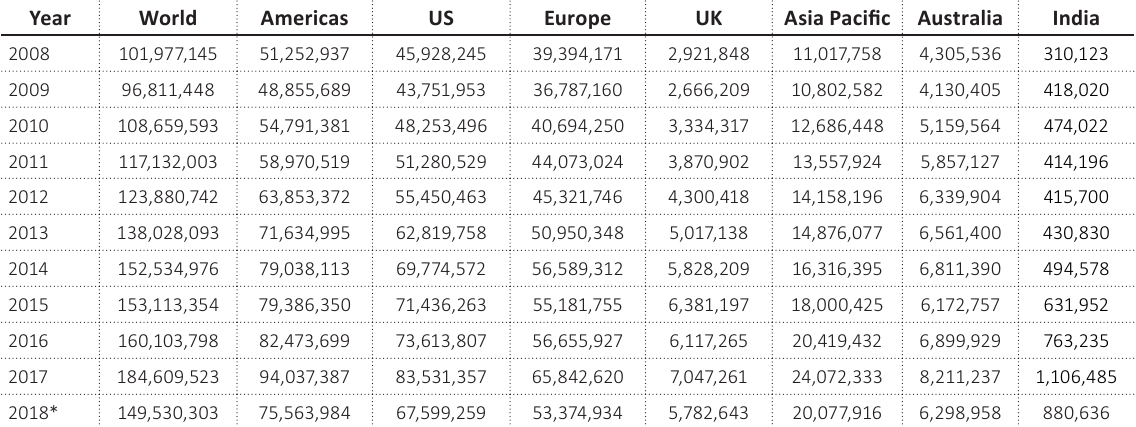
Table 2. Worldwide open-end funds – total net